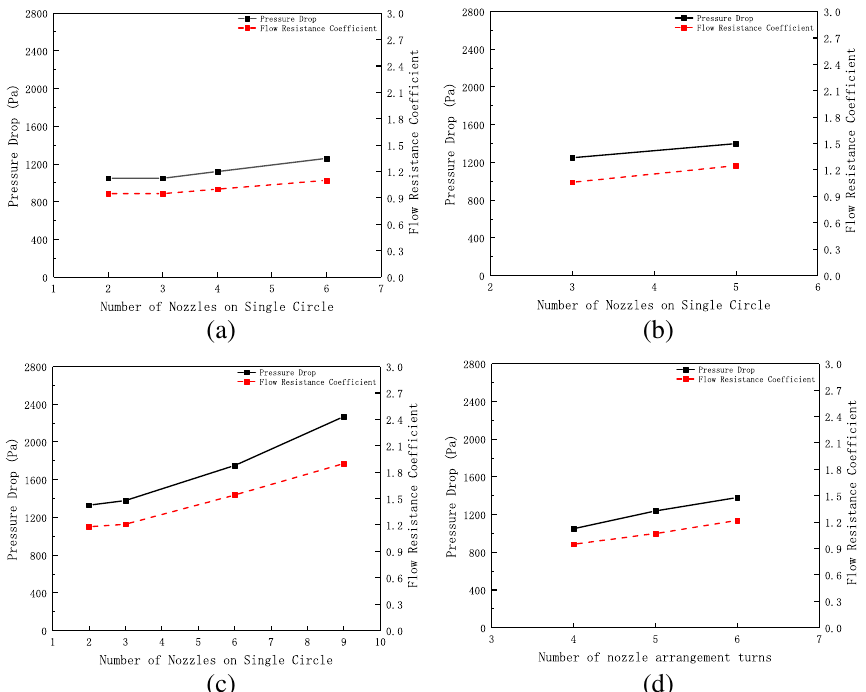
Fig. 15 Variation of fluid pressure drop and flow resistance coefficient with nozzle arrangement in the outer annulus. Total number of nozzles: a 12, b 15, c 18; d number of nozzle